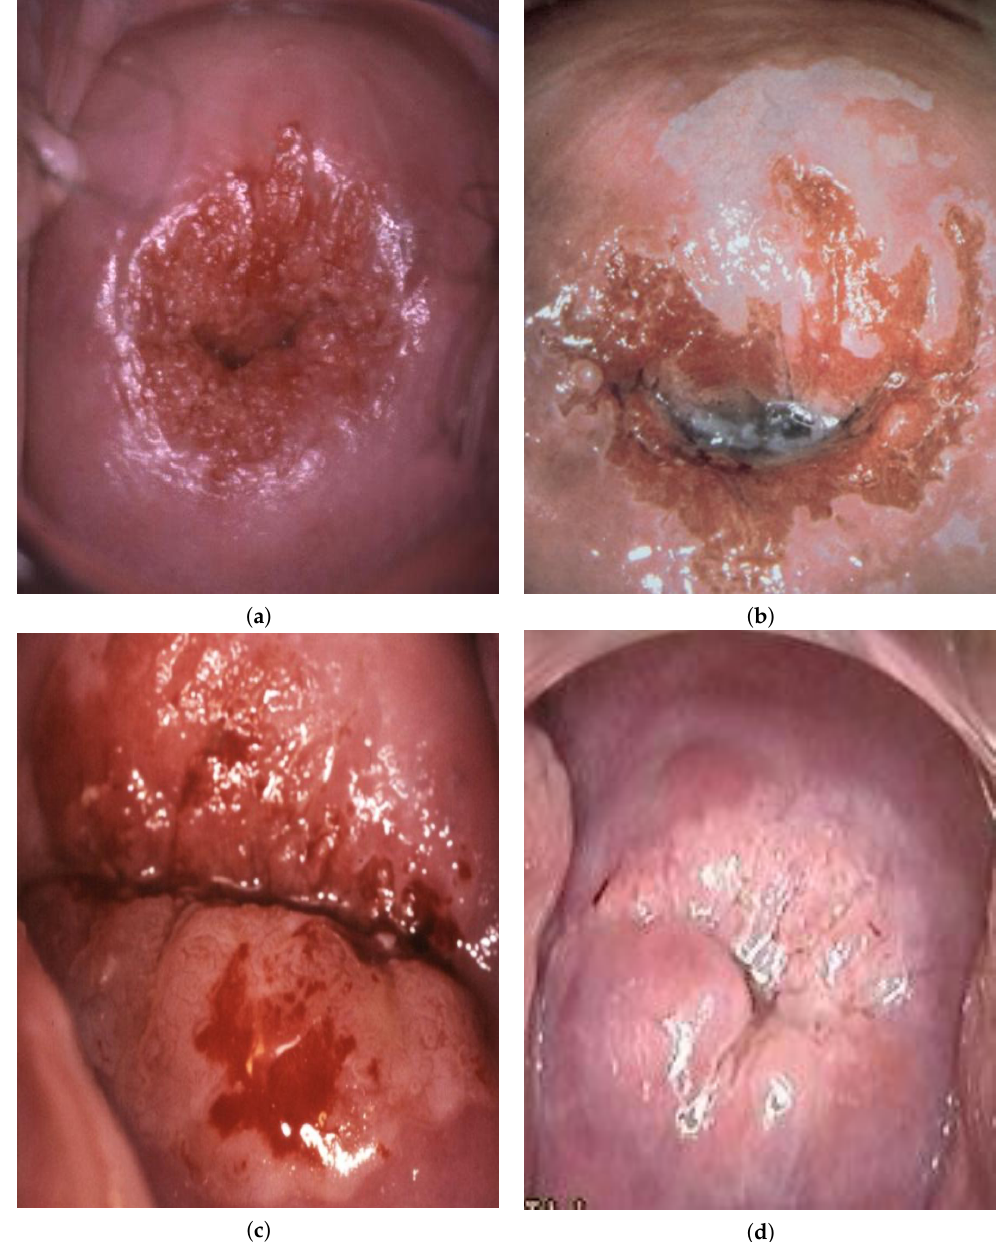
Figure 6. Examples of errors in decisions (predicted/real): ( a ) suspicious for invasion/normal, ( b ) suspicious for invasion/HSIL, ( c ) suspicious for invasion/HSIL, and ( d )